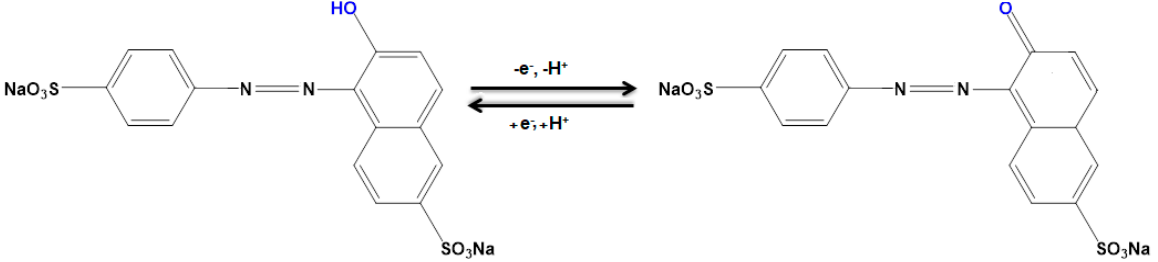
Figure 6. DPVs captured for the oxidation of 100.0 µ M sunset yellow contents on the NiCo 2 O 4 /SPGE at variable pH (2.0, 3.0, 4.0, 5.0, 6.0, 7.0, 8.0 and 9.0). Inset: Variation peak current as a function of solution pH.